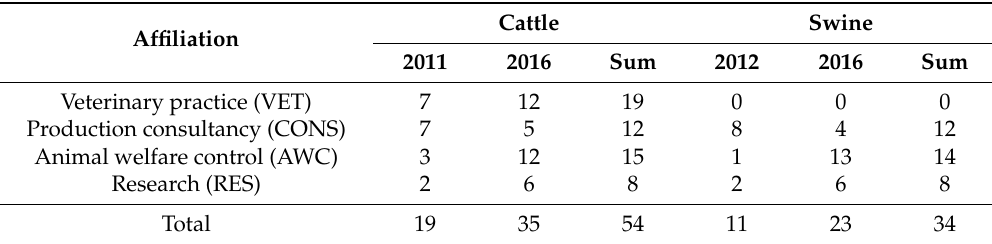
Table 2. The distribution of Danish experts for cattle and swine participating in four online surveys on animal welfare in 2011, 2012 and